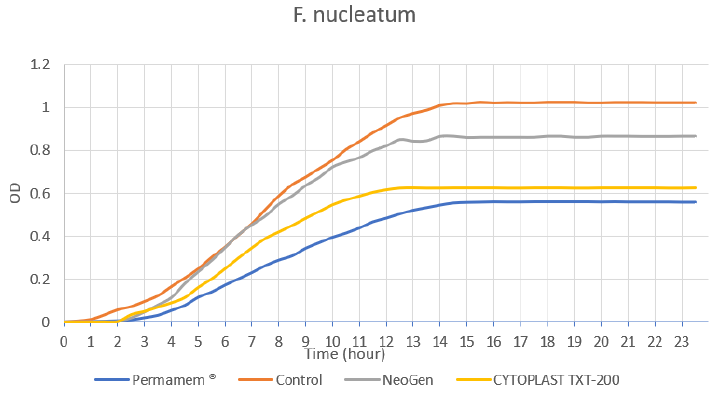
Figure 5. F. nucleatum growth curves.